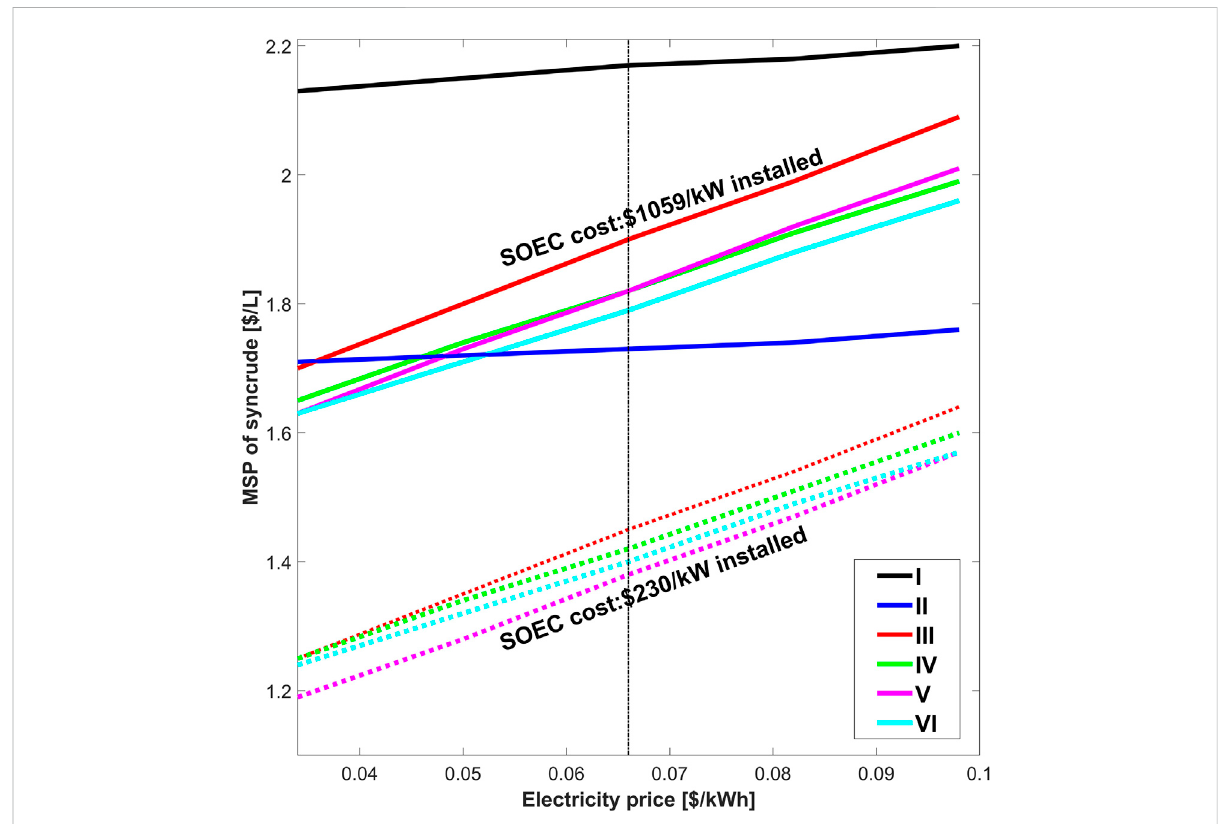
FIGURE 9 Effect of electricity prices and SOEC costs on MSPs of the syncrude. Here, the dotted line refers to MSPs estimated for SOEC installed cost of $230/kWandstackreplacementcostof$52/kWforCaseIII-VIandsolidlinesrefertoMSPsestimatedforSOECinstalledcostof$1,059/kWandstack replacement cost of $448/kW. The vertical dotted line refers to the electricity price of $0.066/kWh. The SOEC cost does not affect Case I and